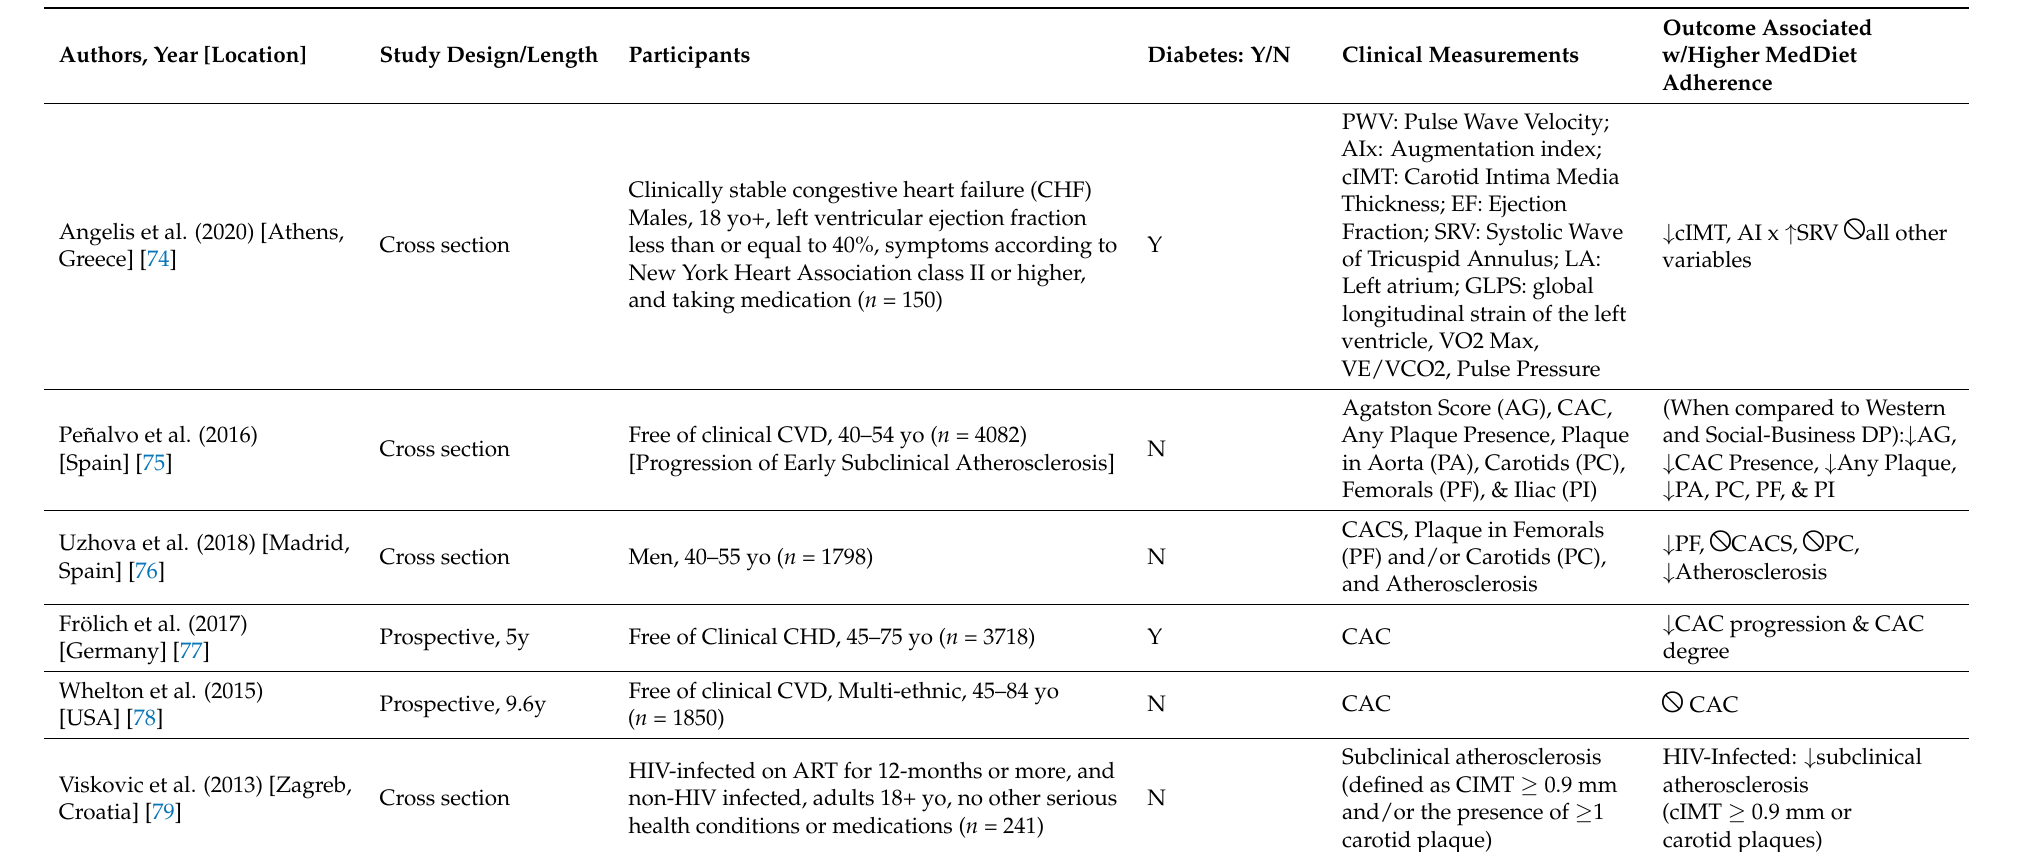
Table 2. Clinical Studies.